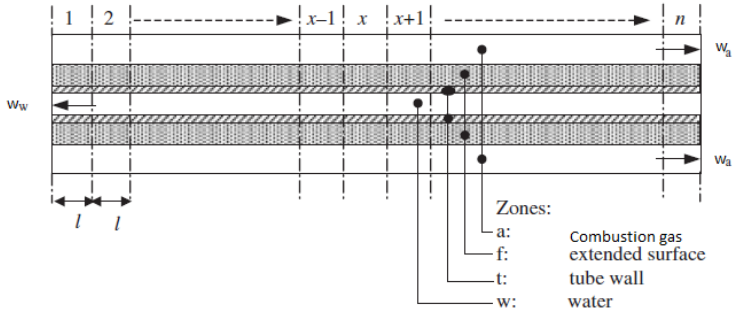
Figure 2. Ideal heat exchanger (edited from